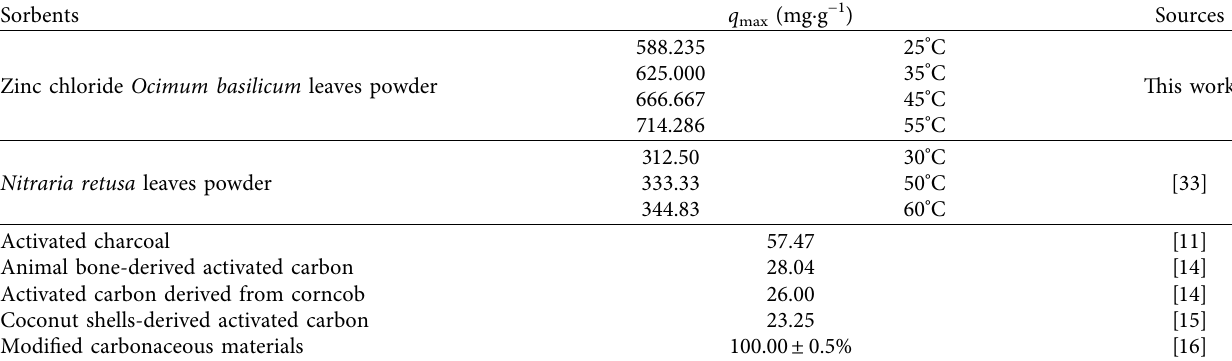
Table 7: MnO − ion sorption capacities on ZCOBLP and other sorbents. 4